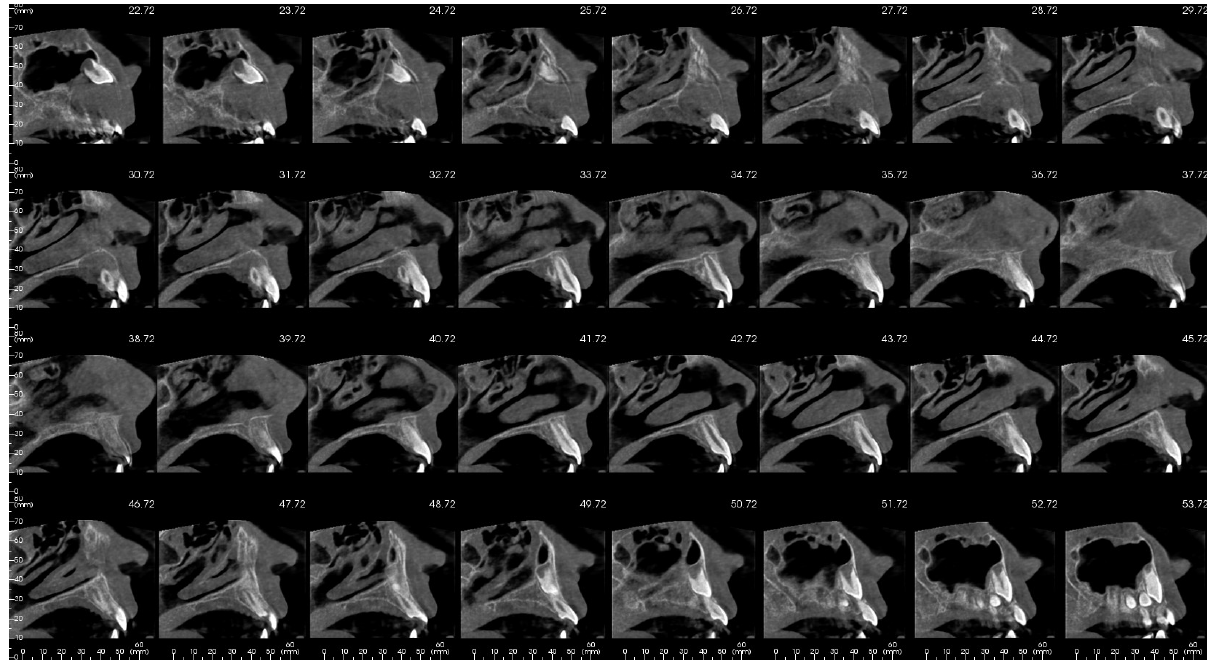
Figure 3. OPG before treatment.